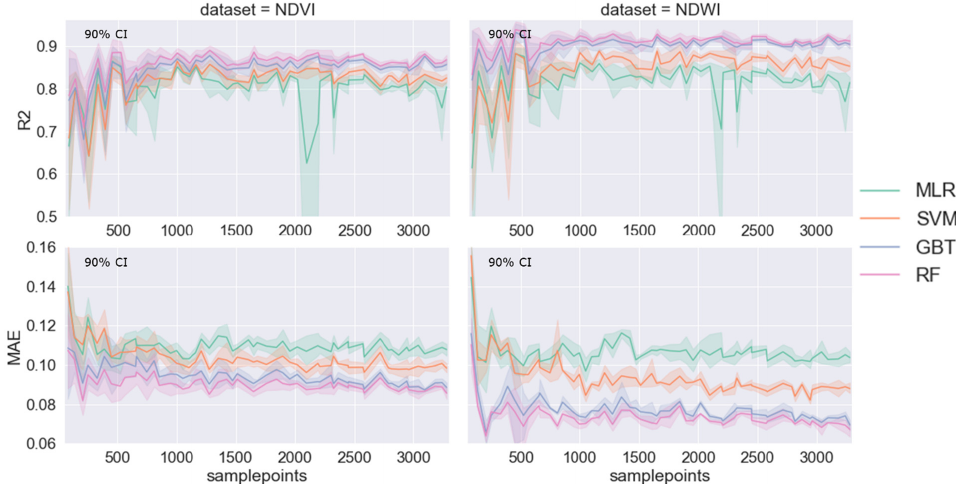
Figure 3. The proportion of model variance explained (R 2 ) and Mean Absolute Error (MAE) are shown for both NDVI and NDWI. Each subplot shows the performance of the respective machine learning model and how it varies based on the number of sample points used to train the model. The shading adjacent to each line represents the 90% confidence interval of the estimate.